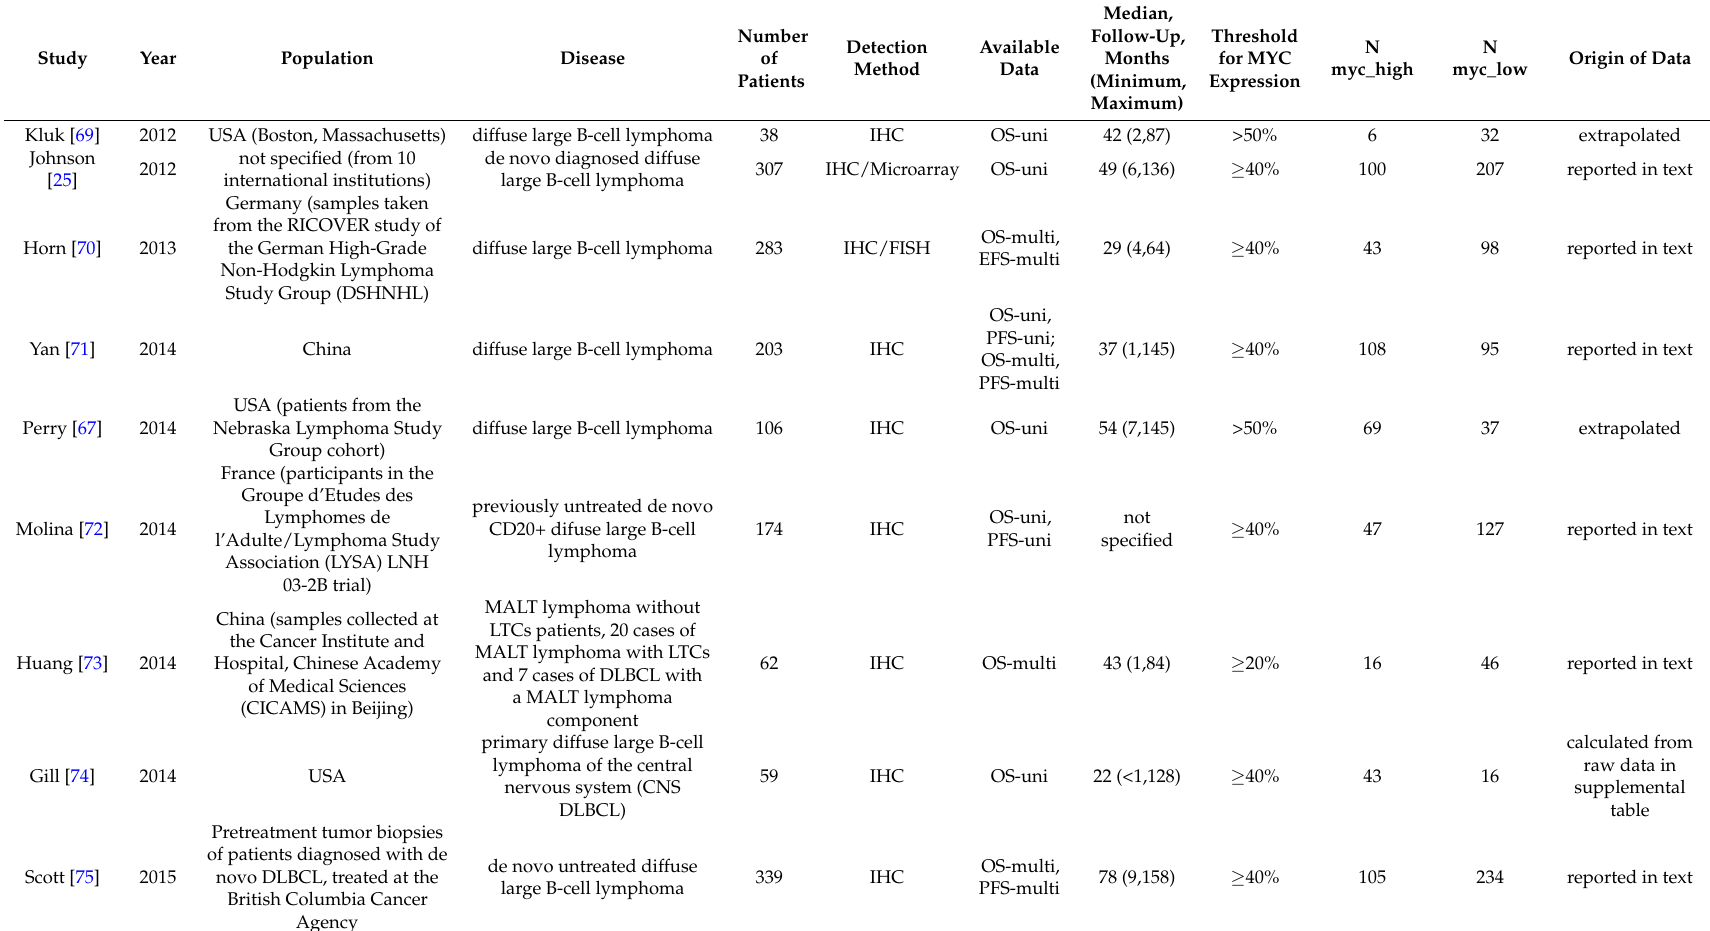
Table 1. Baseline characteristics of eligible